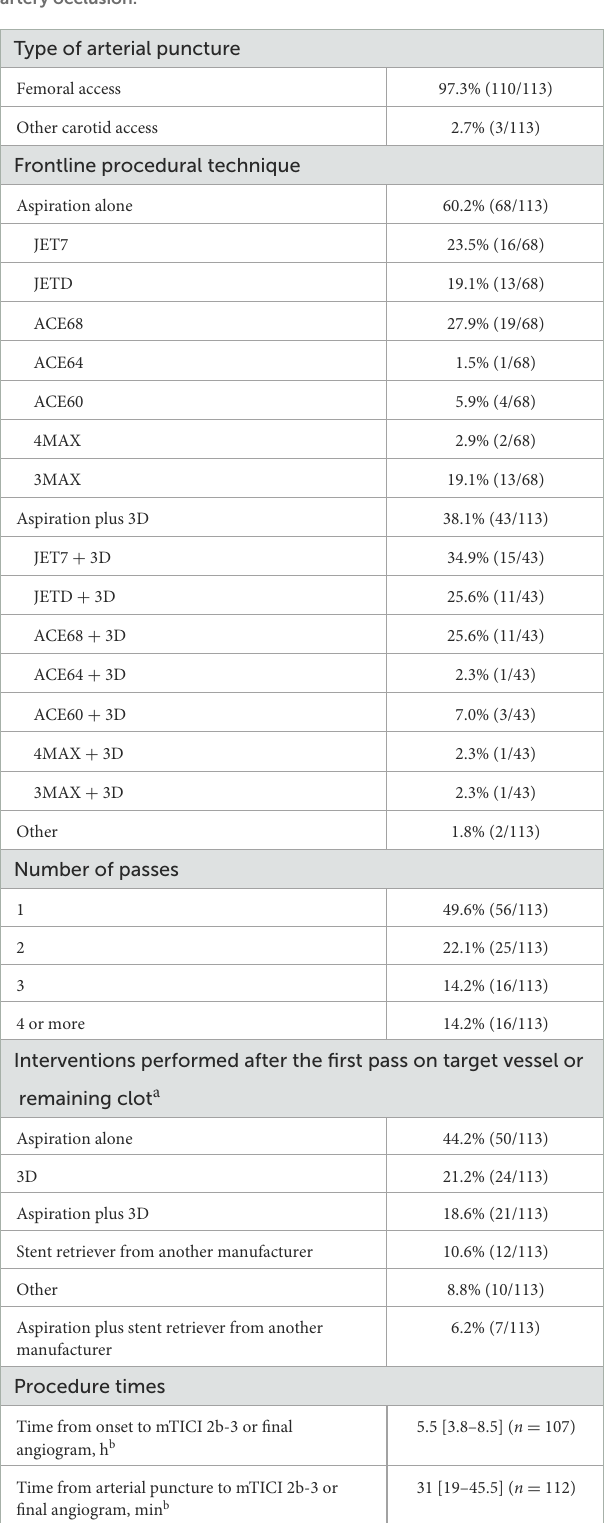
TABLE 3 Outcomes for patients treated with aspiration thrombectomy for acute ischemic stroke due to M2 middle cerebral artery